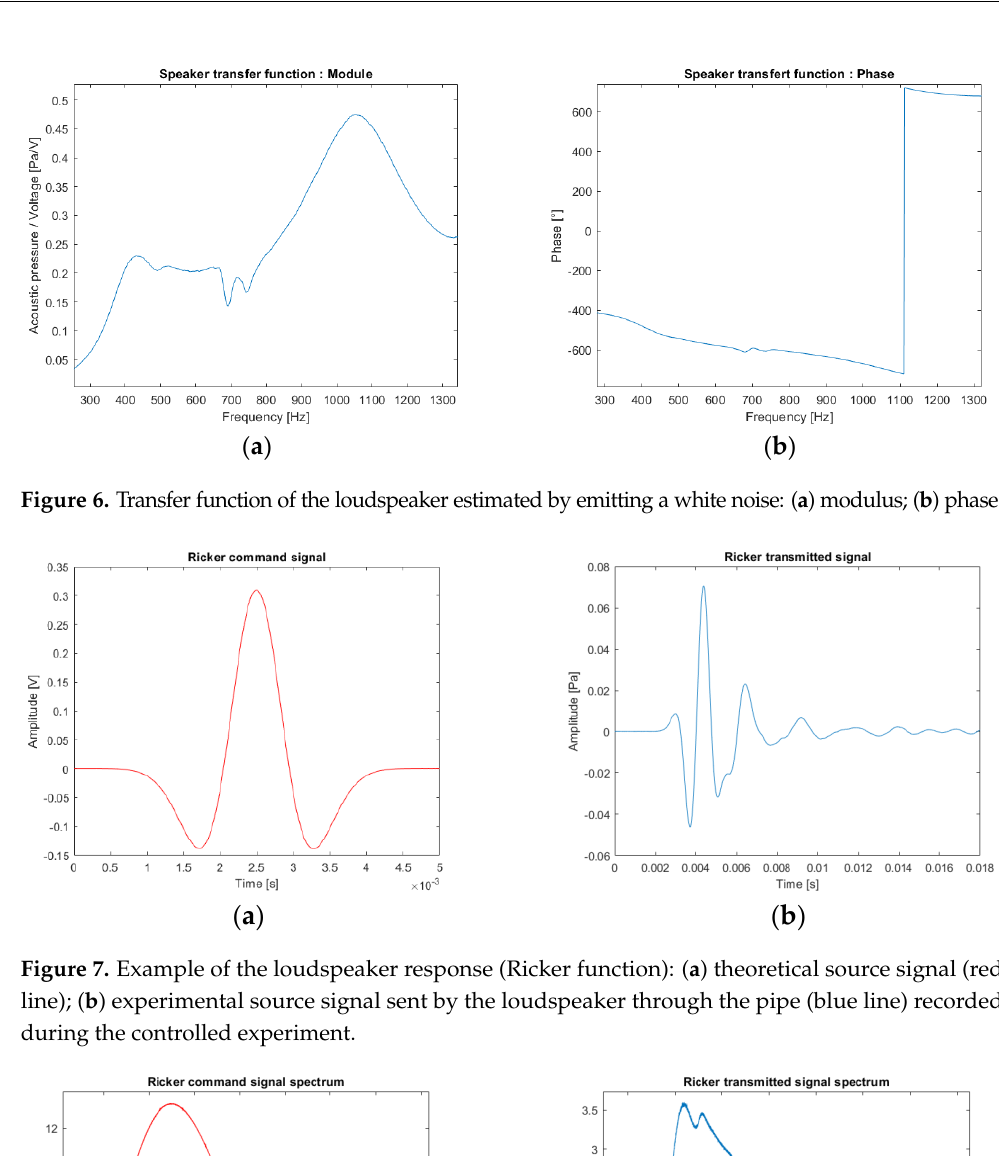
8 of 24 Figure 5. Experimental set-up of the acoustic emission chain: ( a ) diagram of the main components; ( b ) photograph of the material with the battery to power the amplifier.